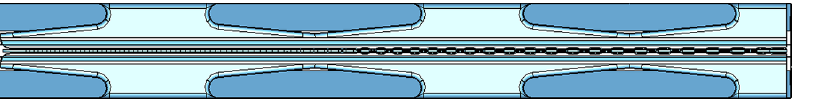
FIG. 1. Full 3D model of the RFQ in MW-STUDIO .